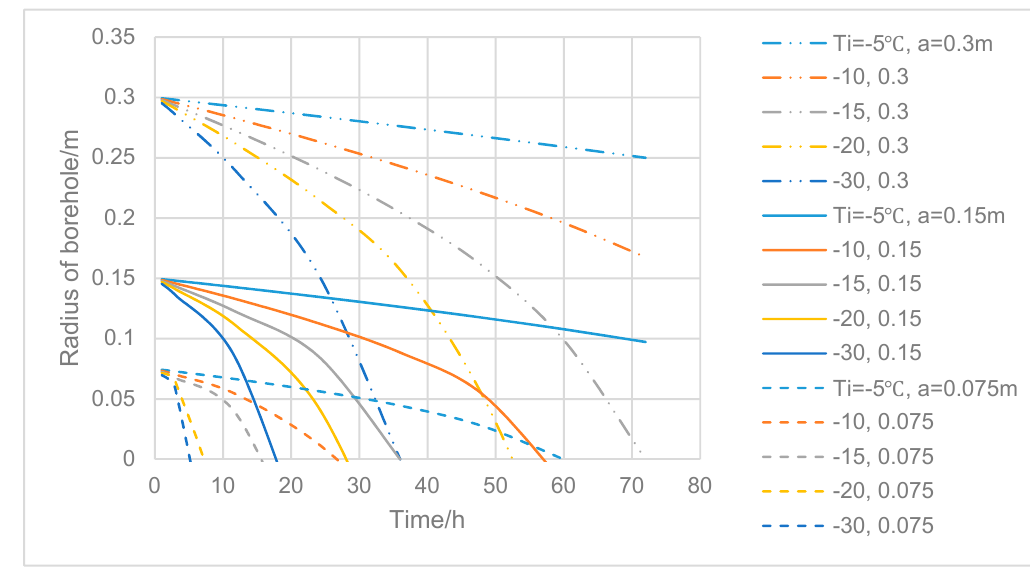
Figure 10. Borehole closure time at different initial borehole radius and surrounding temperatures.